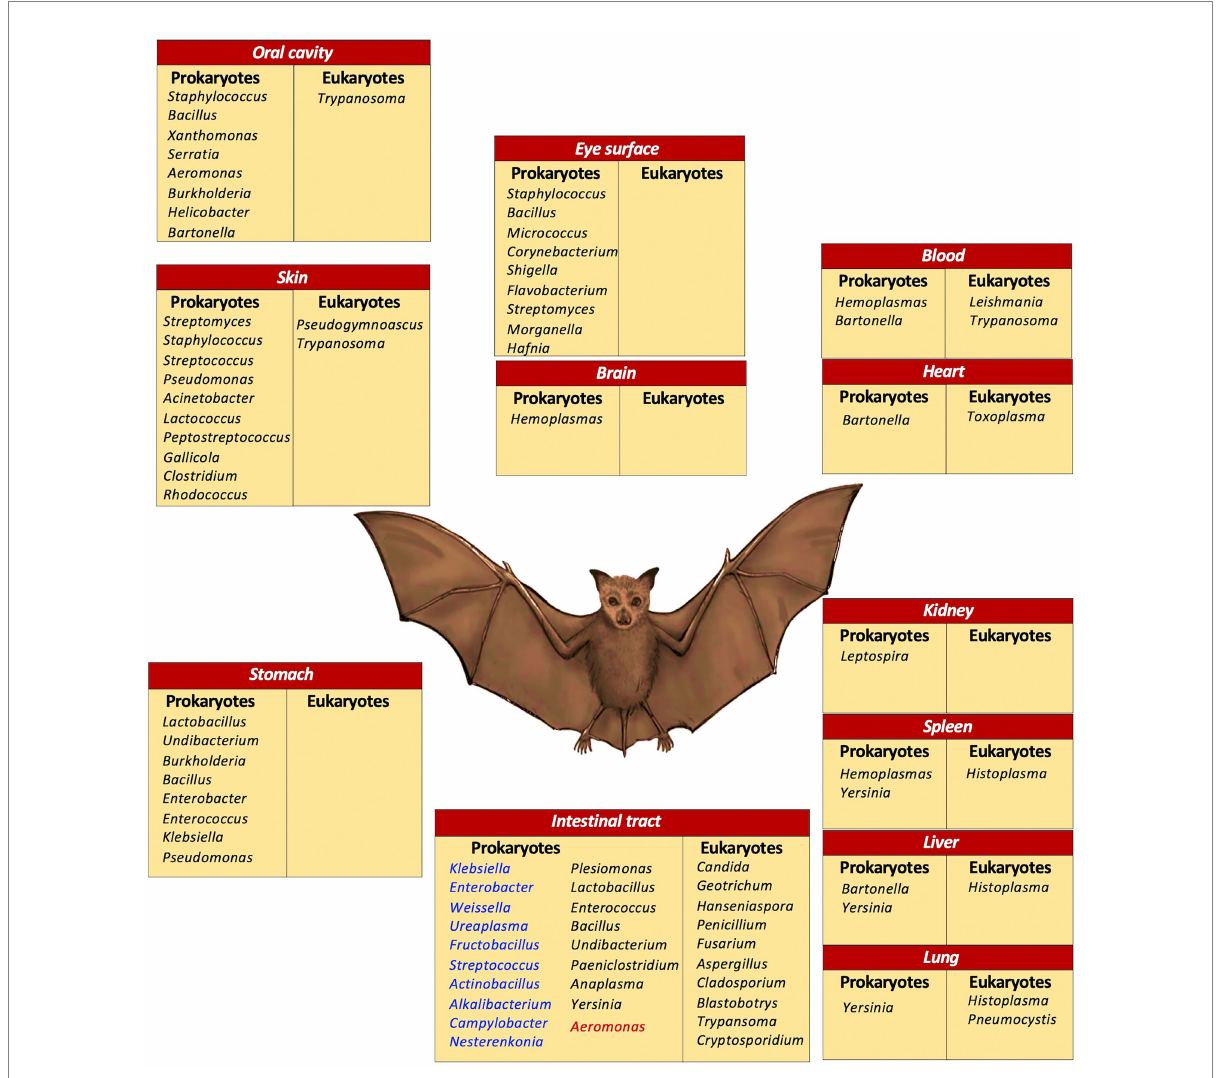
FIGURE 3 Microbial diversity in bats. A compilation of microorganisms at genera level in various body sites. Intestinal tract: blue, frugivores and nectivores; black, insectivores; red,